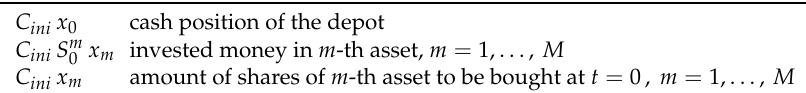
Table A2. Invested money in depot for a portfolio x = ( x 0 , . . . , x M ) T . C ini x